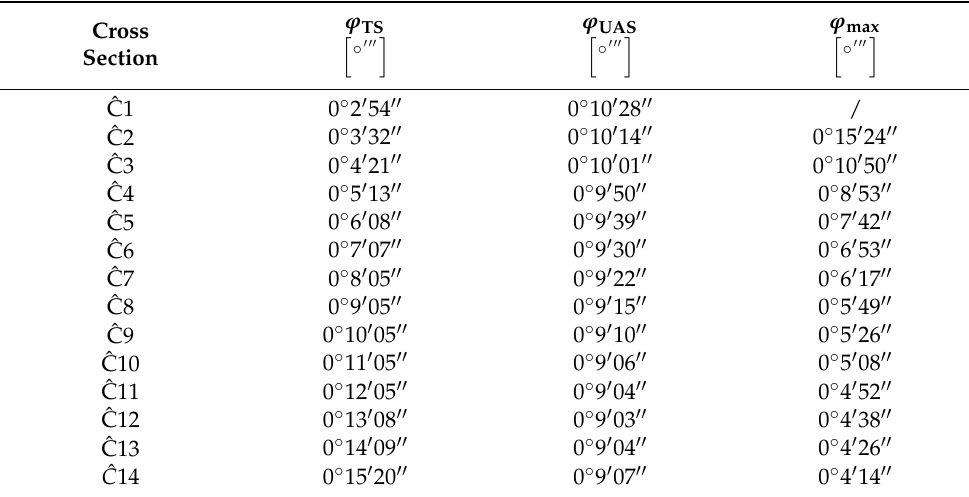
Table 13. Results on chimney inclination evaluation for both the referent TS-based and the validation UAS-based data